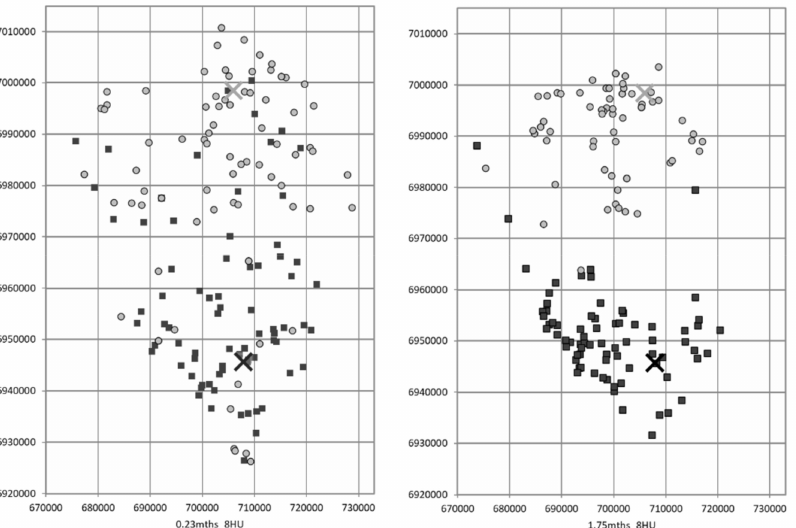
Figure 11. An example of the locations of the harvested sites by two of the eight harvester-forwarder (HU) units for 0.23 and 1.75 months of harvesting site reserves with 8 HU. The harvested sites of the seventh replication of two HUs are marked in black boxes (1 HU) and grey circles (2 HU). The base locations are marked as crosses in respective